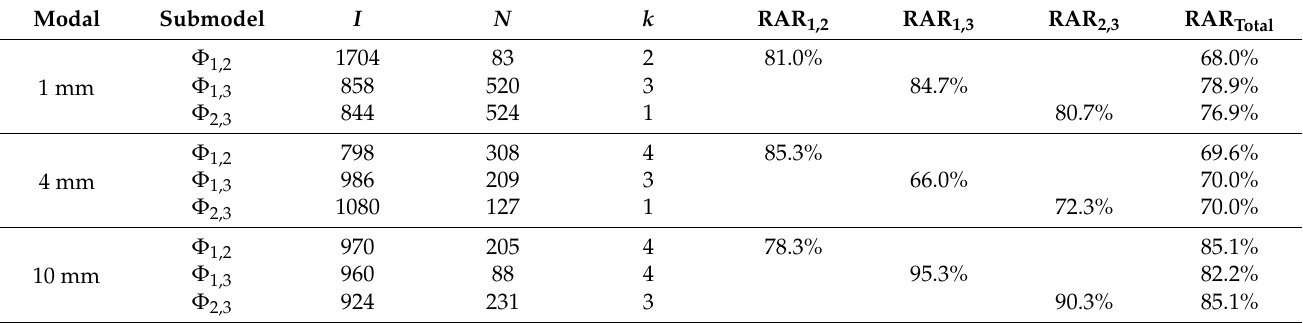
Table 3. Modeling discrimination effects of the 2-category priority’s compensation models of three measurement modals.